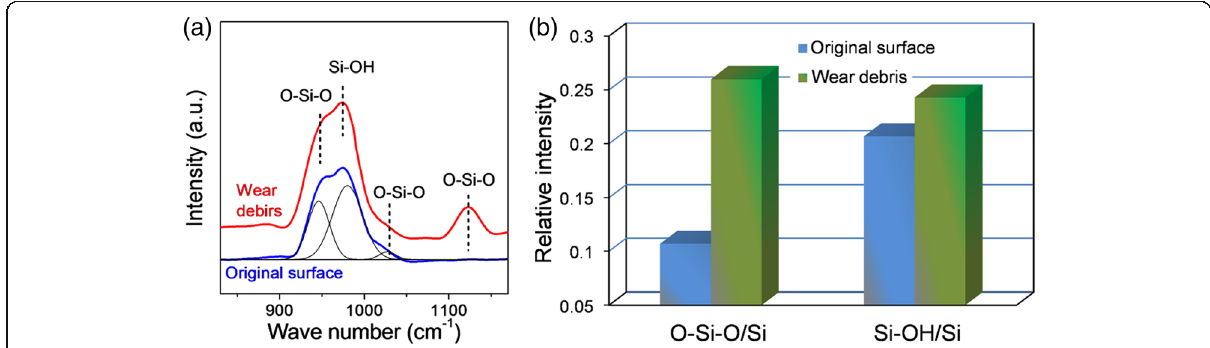
Fig. 5 Raman spectra of original Si surface and wear debris at the end of scale formed against SiO 2 sphere in humid air. a Bond detection curves. b Relative intensities of O-Si-O/Si and Si-OH/Si estimated from ( a ). Normal load in the wear tests was 1 N, and the number of sliding cycles was 2000